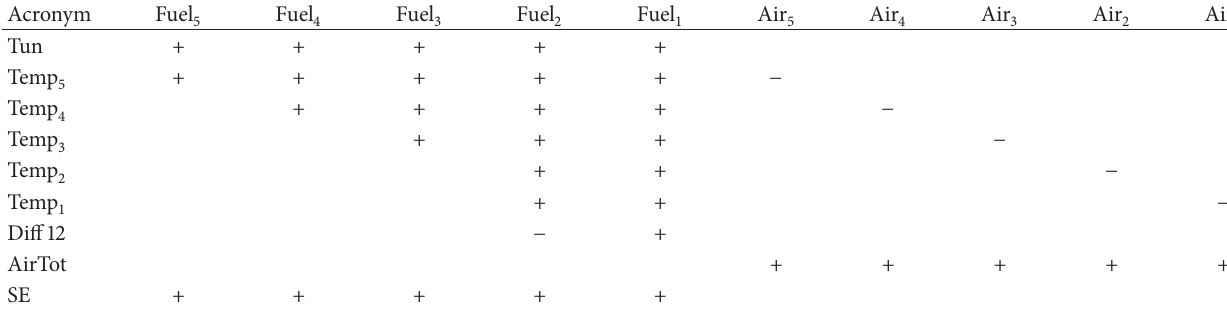
Table 4: The CVs-MVs mapping matrix.